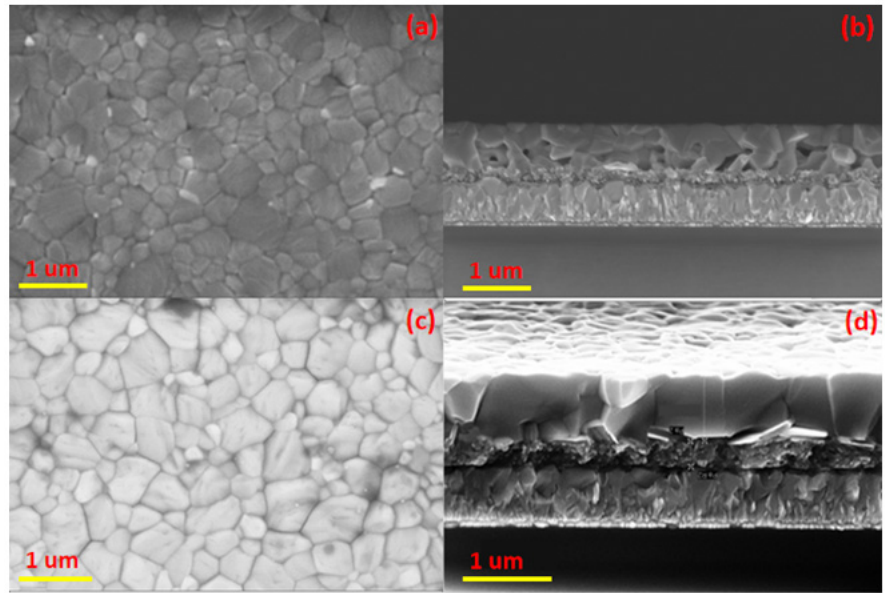
Figure 3. Top view and cross-sectional view of the SEM images for one-step ( a , b ) and two-step ( c , d ).